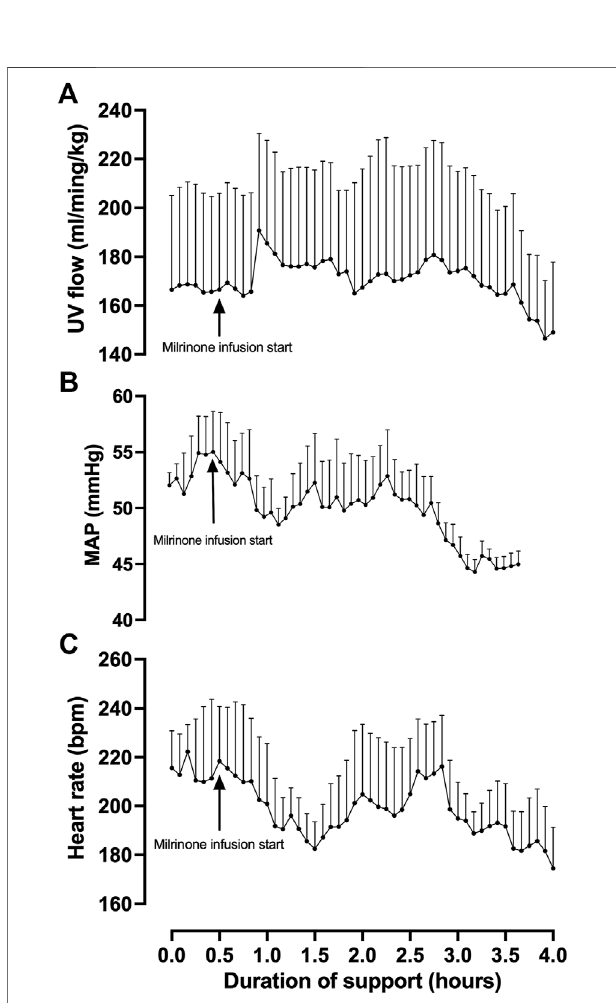
FIGURE 6 | Effects of milrinone lactate infusion on fetal pig indexed UV fl ow (A) , MAP (B) , and HR while maintained using a pumped AP circuit. Maintenance infusion of milrinone lactate was used in successful AP experiments ( n = 5) for hemodynamic support. “ Milrinone infusion start ” indicates the time point at which milrinone lactate IV infusion into the circuit began. Data are presented as 5-minute epochs and expressed as mean ± SEM.